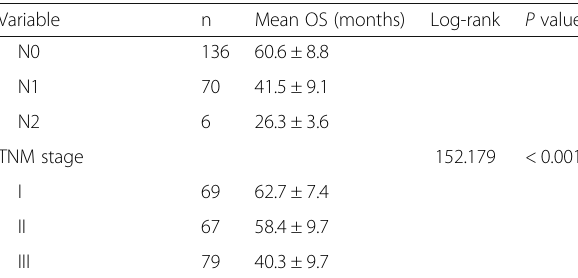
Table 5 Results of univariate analyses of overall survival (OS)